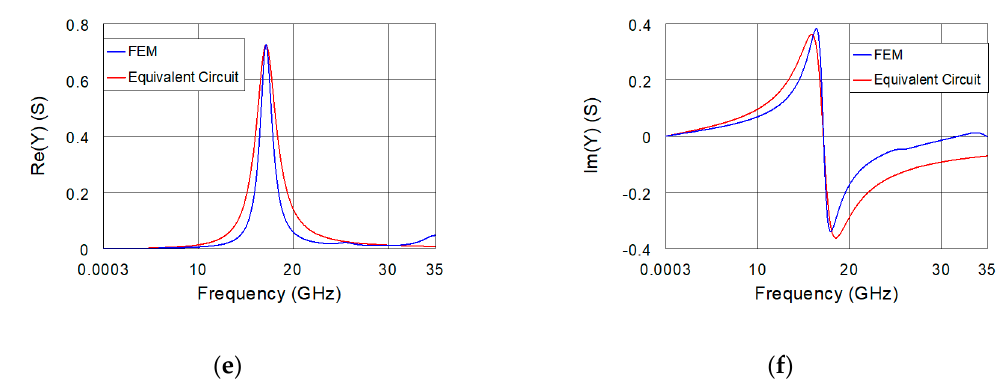
Figure 8. FEM (blue lines) and equivalent-circuit (red lines) simulations of the ( a , c , e ) real and ( b , d , f ) imaginary parts of the admittance from 0.3 MHz to 35 GHz for the IDC sensor loaded with lossless MUTs having a real part of the relative permittivity of ( a , b ) 15; ( c , d ) 40; and ( e , f ) 70.